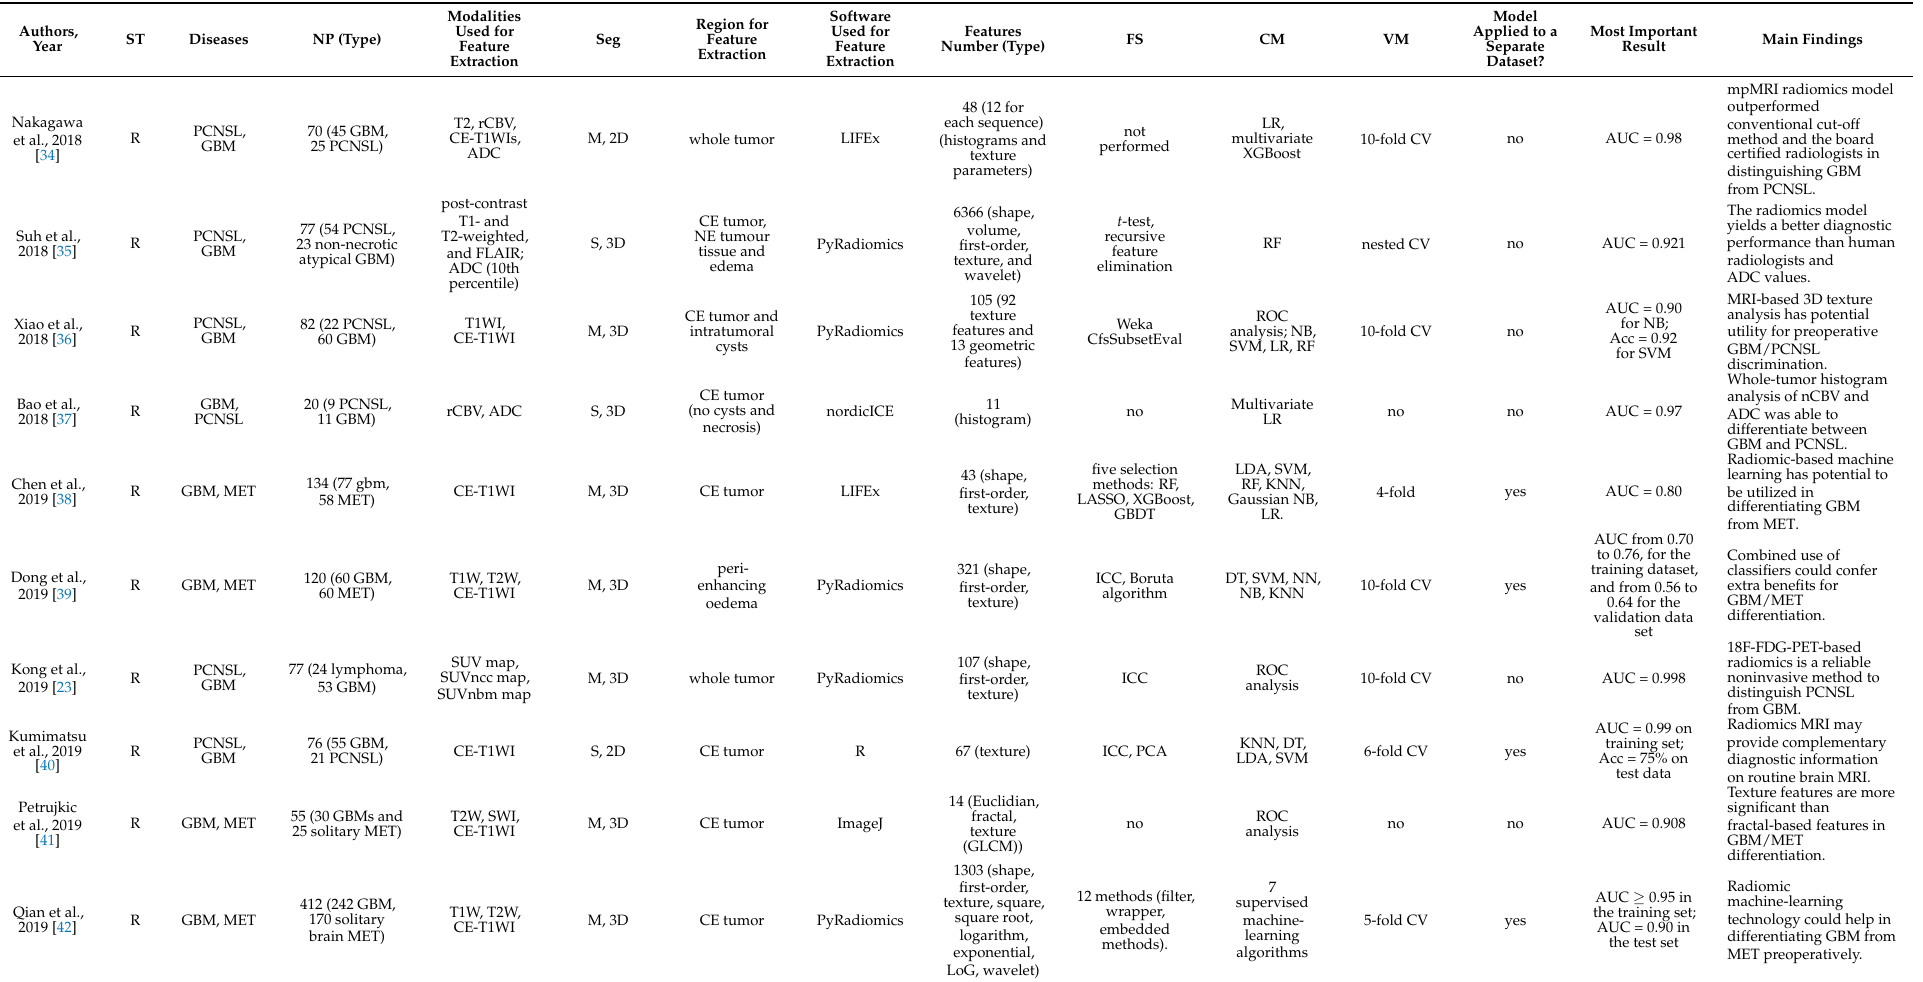
differentiatingGBMfrom